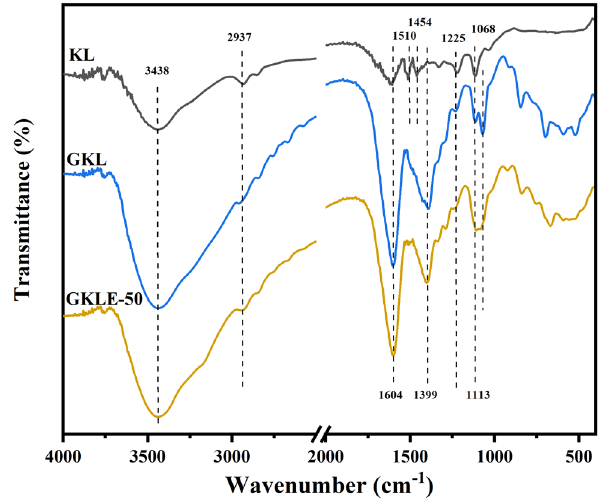
Figure 1: The FT - IR spectra of KL, GKL, and GKLE -